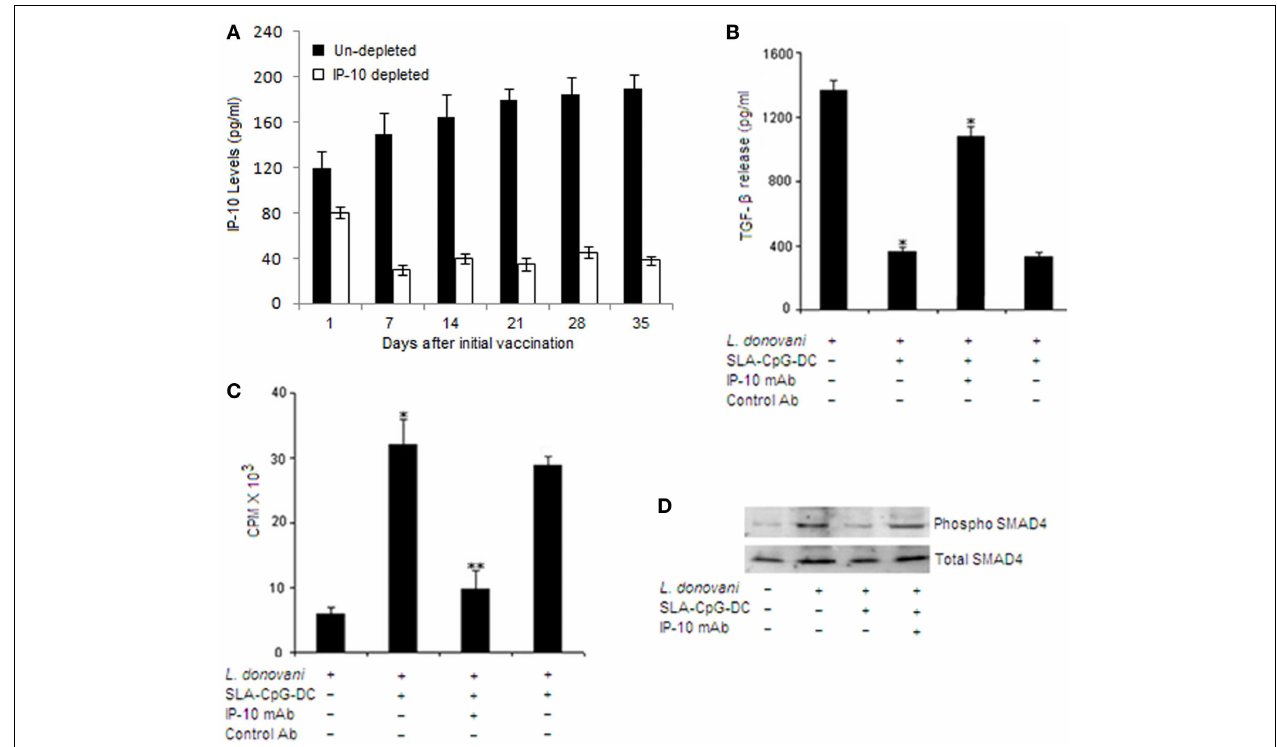
cells and CD4 + CD25 − T cells were purified from spleen of differently treated mice (see Materials and Methods) after 28days post-infection. CD4 + CD25 − T cells (5 × 10 5 ) andT-depleted, mitomycin C-treated syngeneic APCs (5 × 10 5 ) were stimulated with SLA (10 µ g/ml) in the presence of splenic CD4 + CD25 + T cells (1:1) for 4days. Proliferation was determined by an 18-h (3H) thymidine incorporation assay. Data were presented as cpm × 10 3 . ** P < 0.001 compared with infected sets. (D) In a separate experiment, CD4 + CD25 + Treg cells (2 × 10 6 ), purified from spleen of indicated groups of mice, were stimulated with SLA for 30 and 60min.The cells were lysed and subjected to Western blotting with anti-pSMAD4 and anti-SMAD4 as described in Section “Materials and Methods”.The experiments were carried out three times, of which one set of representative data is